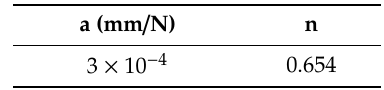
Table 4. Values of the compliance